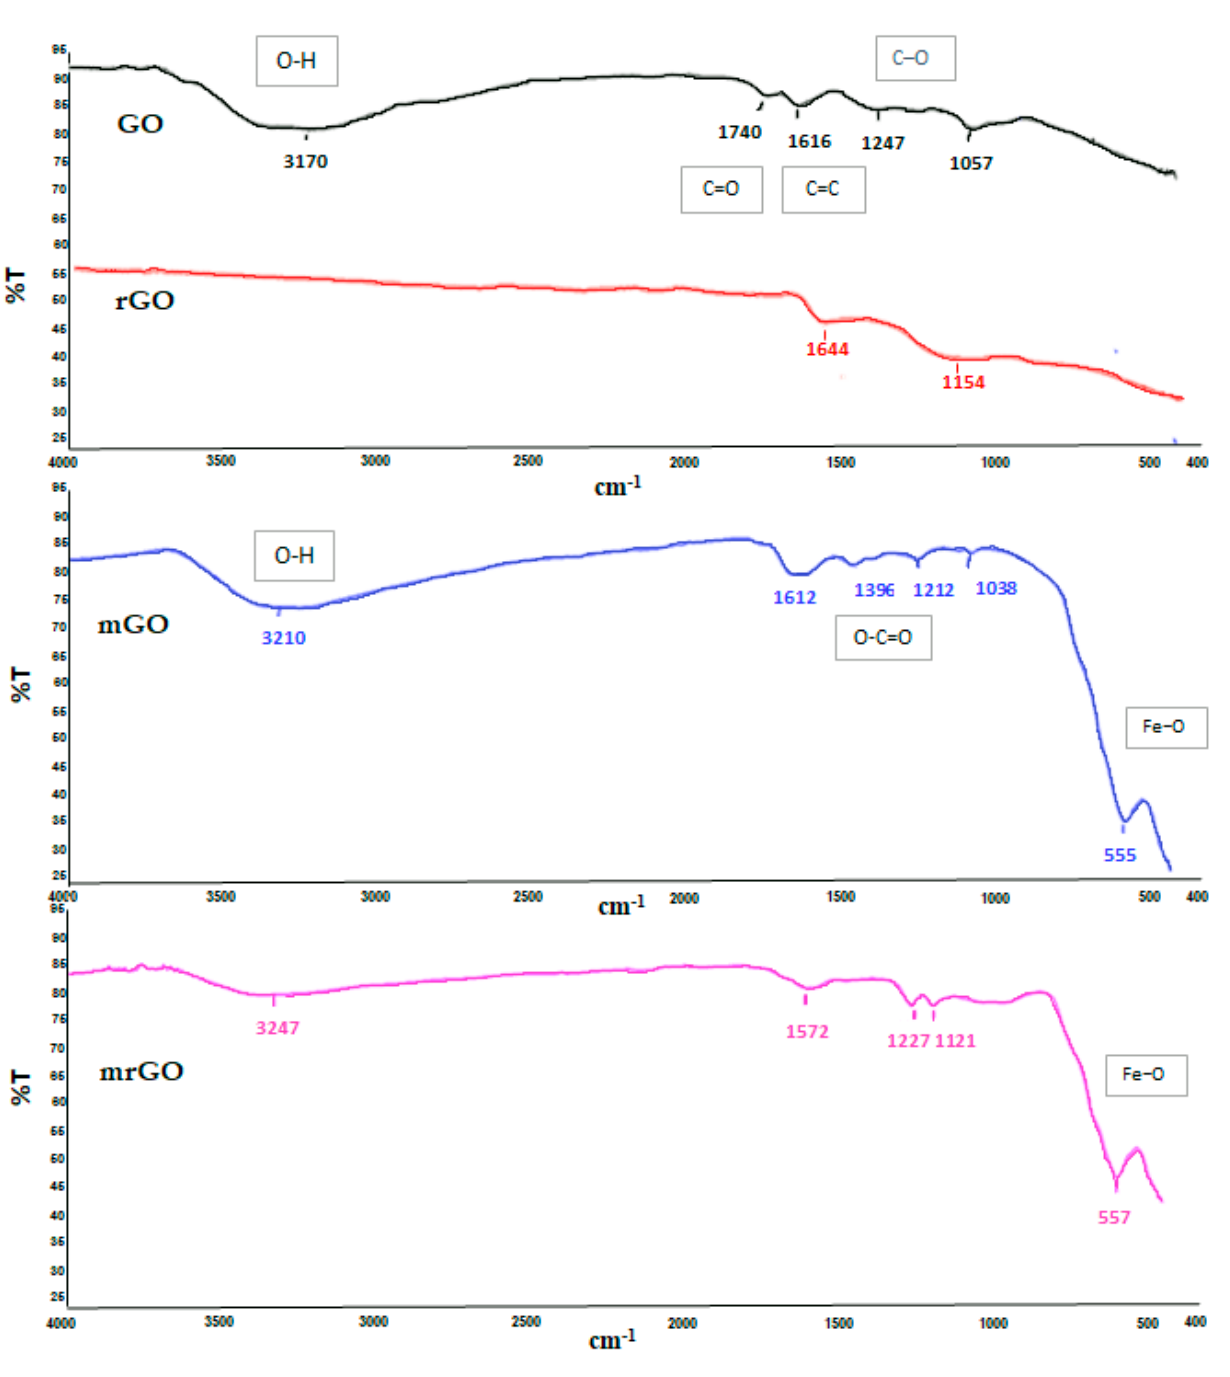
Figure 2. FT-IR spectra of GO, rGO, mGO, and